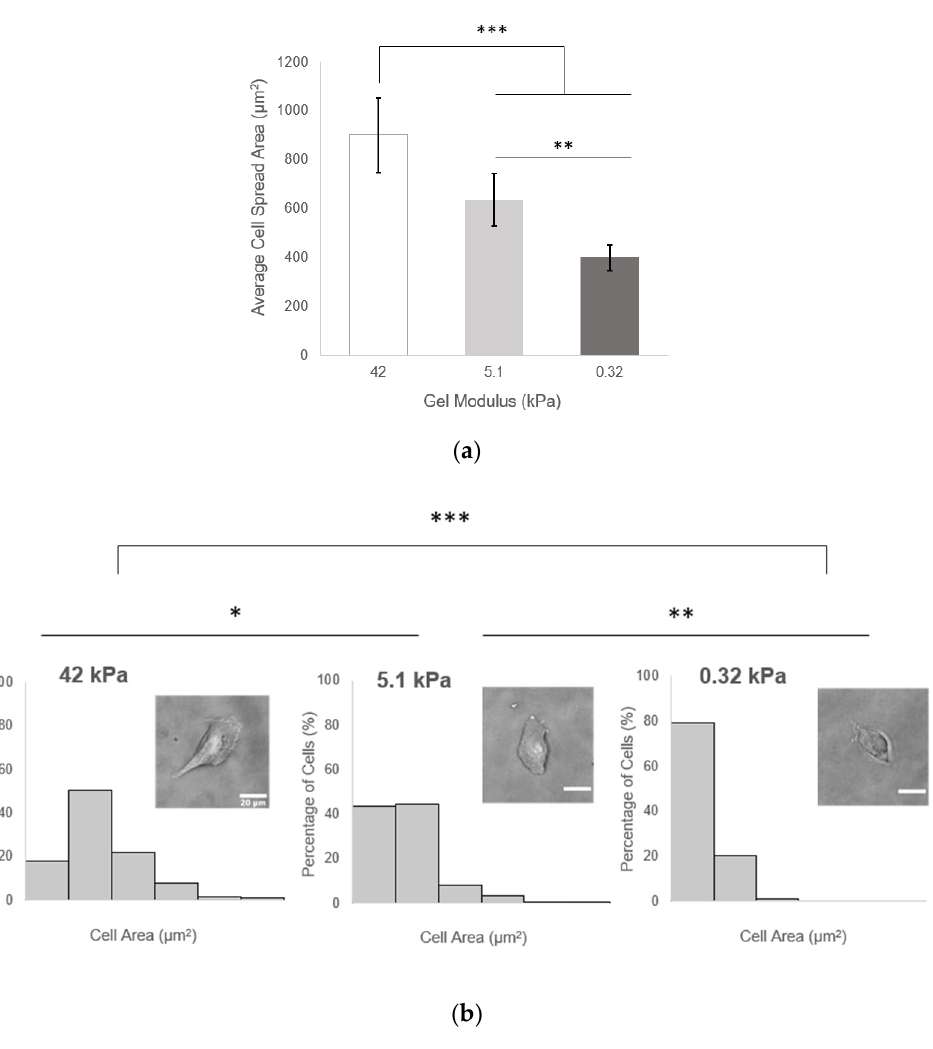
Figure 7. Fibroblast spreading is directly related to hydrogel stiffness. ( a ) average cell area at 24 h after seeding. Values reported as mean ± S.D. ** p < 0.001, *** p < 0.0001, indicating a statistically